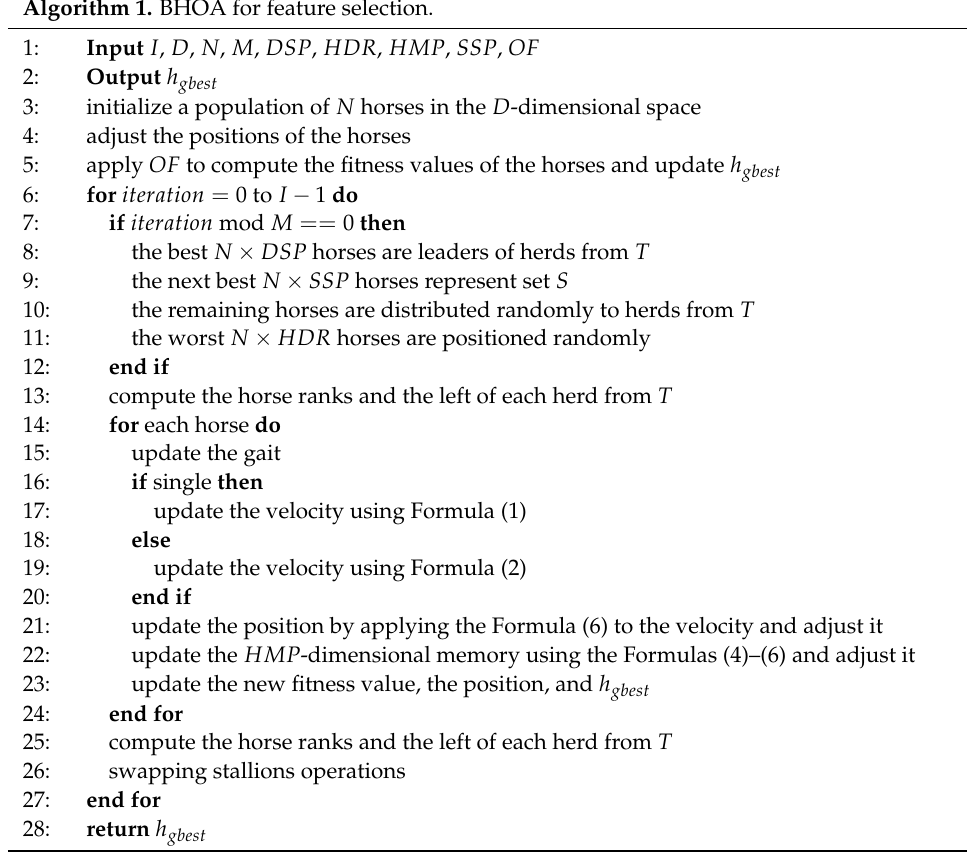
Algorithm 1. BHOA for feature